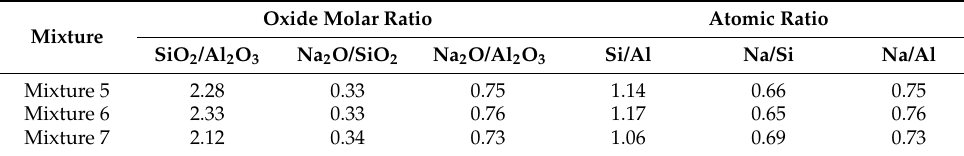
Figure 12. Ternary diagram of mass percentage ratios of Al, Si, and Na oxides in M5, M6, and M7 mixtures including all dry components of binder (without standard sand). Table 4. Molar ratio of Si, Na, and Al oxides and atomic ratio of Si, Na, and Al in the designed mixtures M5, M6, and M7 for binder components.